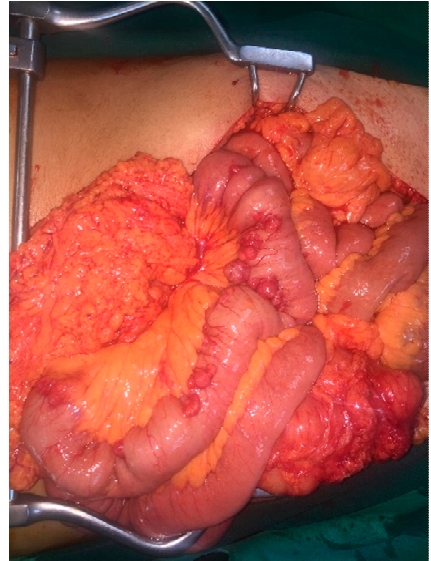
Figure 1. Image of the GISTs during the surgery.